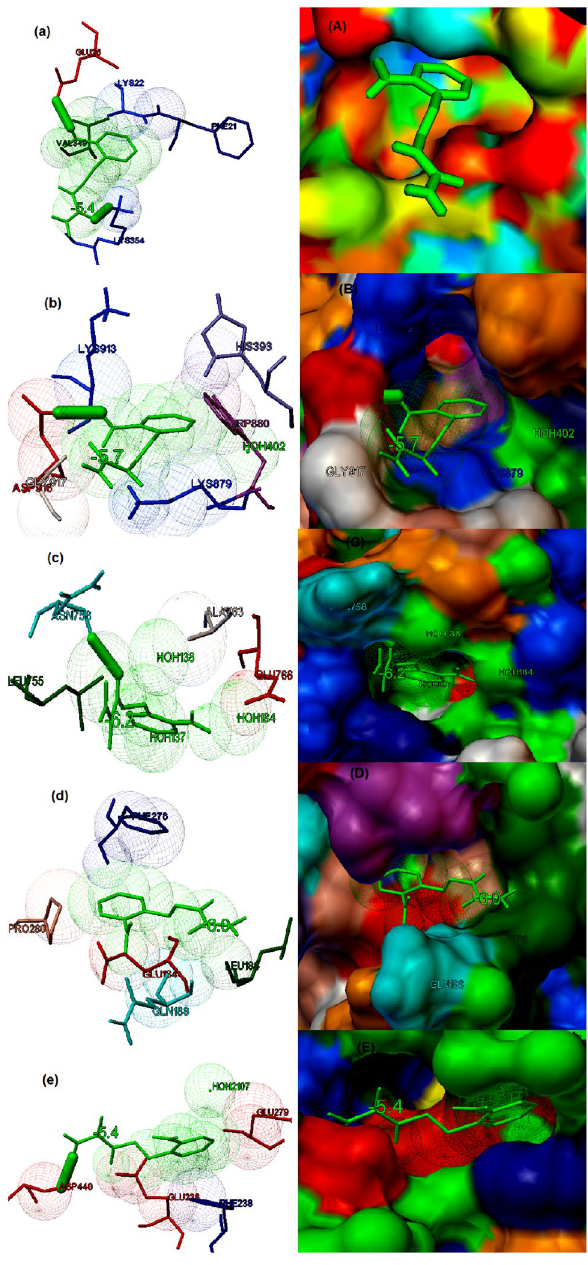
Figure 6. The binding potential of the compound 2 to the five selected cancer receptor studied by molecular docking ( a ) The best binding Interaction of (E)-2-(2-aminobenzylidene) hydrazinecarboxamide and β-catenin predicted by molecular docking with binding energy of − 5.9 kcal/mol. The ligand is highlighted in green coloured stick figures. The amino acid residues present in the binding activity of the β-catenin receptor is also highlighted ( b ) The best binding Interaction of (E)-2-(2- aminobenzylidene) hydrazinecarboxamide and Epidermal growth factor receptor (EGFR) with binding energy of − 5.7 kcal/ mol. Thick green coloured stuck indicate hydrogen bonding. The ligand is highlighted in green coloured stick figures and the amino acid residues present in the binding activity of the EGFR receptor is also shown in the figure ( c ) The best binding Interaction of ((E)-2-(2-aminobenzylidene) hydrazinecarboxamide and Kinase domain of Human HER2 (erbB2) predicted by molecular docking with binding energy of − 6.2 kcal/mol. The ligand is highlighted in green coloured stick figures and the amino acid residues present in the binding activity of the EGFRK receptor are also highlighted. ( d ) The best binding Interaction of (E)-2-(2-aminobenzylidene) hydrazinecarboxamide and Cyclin D1-cyclin-dependent kinase 4 with binding energy of − 6.0 kcal/mol. Thick green coloured stuck indicate hydrogen bonding. The ligand is highlighted in green coloured stick figures and the amino acids present in the binding activity of Cyclin D1-cyclin-dependent kinase 4 is also highlighted. ( e ) The best binding Interaction of (E)-2-(2-aminobenzylidene) hydrazinecarboxamide and RAC-beta serine/threonine-protein kinase B with binding energy of − 5.4 kcal/mol. The ligand is highlighted in green coloured stick figures and the amino acids present in the binding activity of the RAC-beta serine/threonine-protein kinase B receptor is also shown in the figure. The part shown in uppercase indicate the molecular surface display of the best binding pose of the interaction between the compound 2 and selected cancer